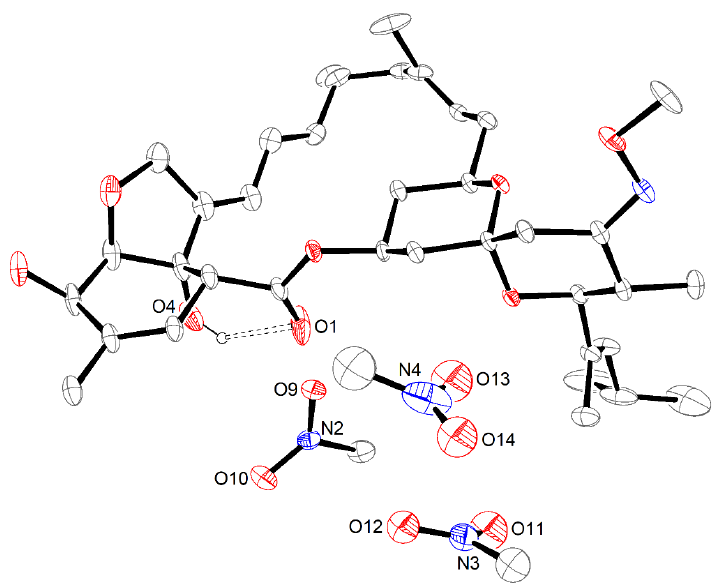
Figure 5. Asymmetric unit of the crystal structure of the nitromethane solvate Moxi·1.5MeNO 2 showing a one moxidectin and three nitromethane molecules. For the disordered nitromethane molecules only one position is shown. Anisotropic displacement parameters are shown with 30% probability.